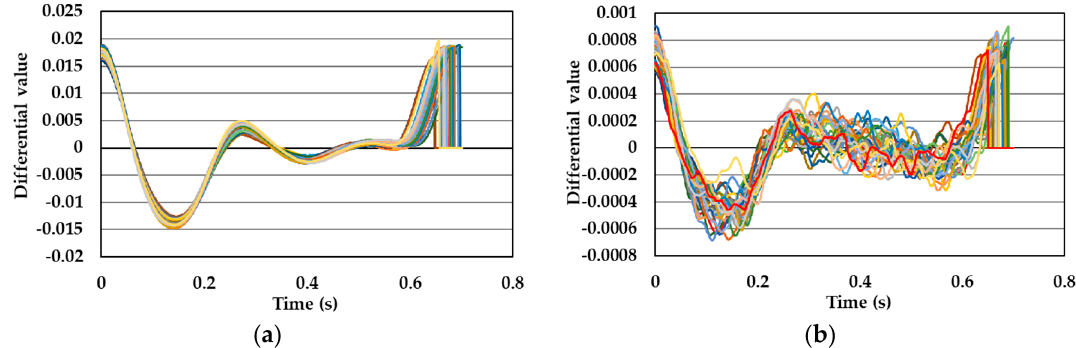
Figure 5. The single pulse wave signals of subject A: ( a ) POF-FBG sensor and ( b ) silica-FBG sensor.